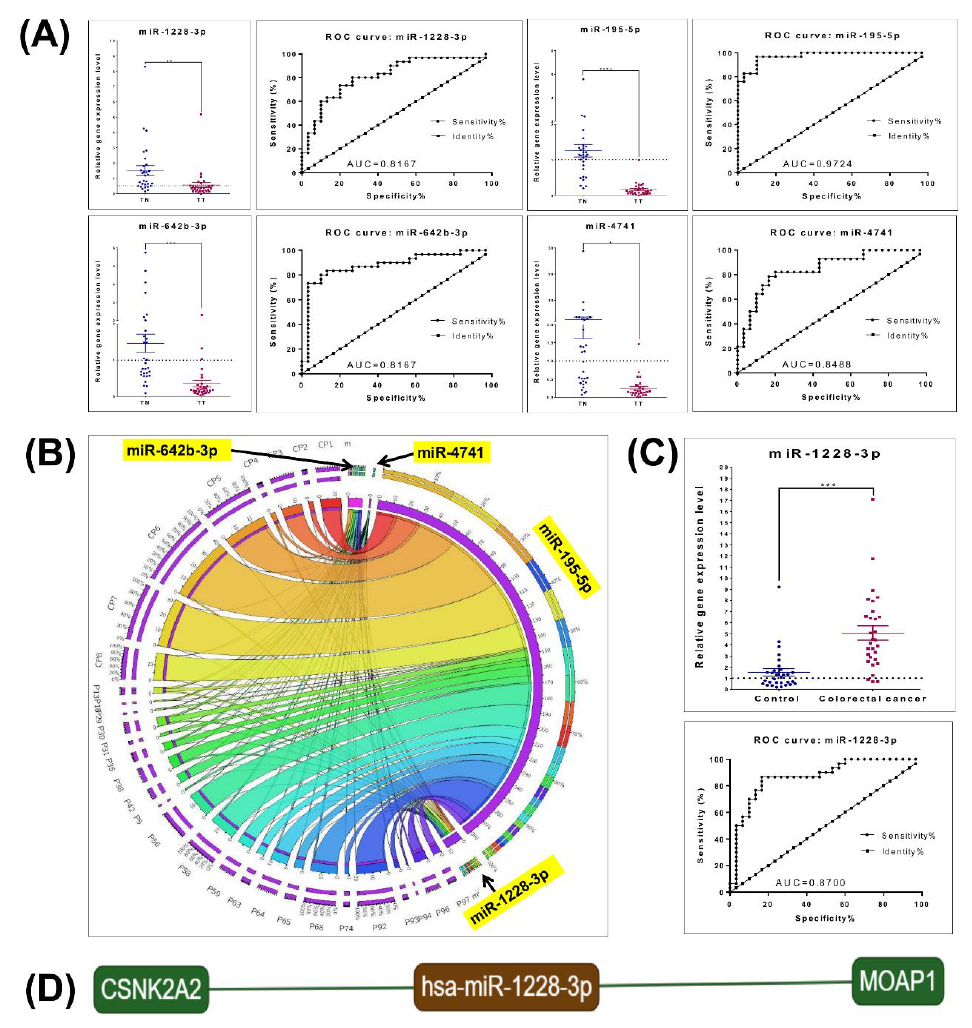
Figure 4. Tissue and plasma qRT-PCR data validation, the evaluation of the miRNA expression level shows relevant di ff erences. ( A ) Expression level of miR-1228-3p, miR-642b-3p, miR-195-5p and miR-4741 in tumor tissue and normal tissue, and receiver operating characteristic (ROC) curve; ( B ) Circos plot of the integrated miRNA spatial signature showing the heterogeneity of the expression level; ( C ) miR-1228-3p expression level in plasma colorectal patients and healthy controls and ROC curve; ( D ) miR-1228-3p direct target, generated using miRtargetlink; (* p ≤ 0.05, ** p ≤ 0.01, *** p ≤ 0.001, **** p ≤ 0.0001) .